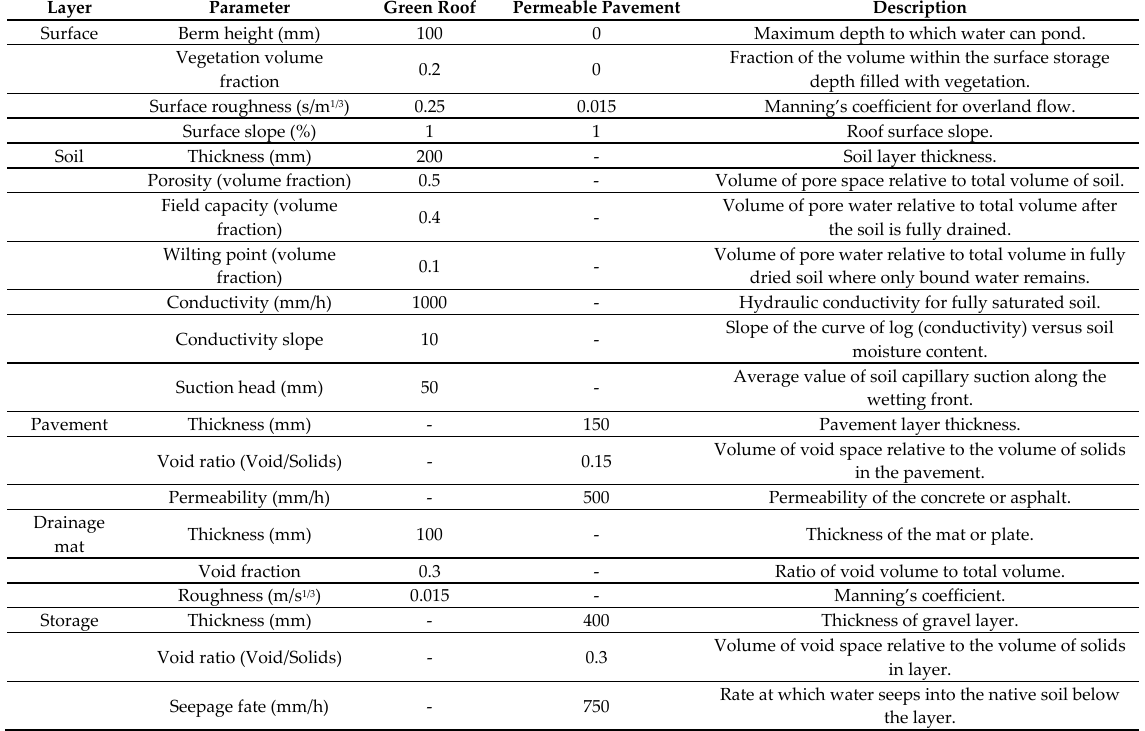
Table 2. Parameters of LID